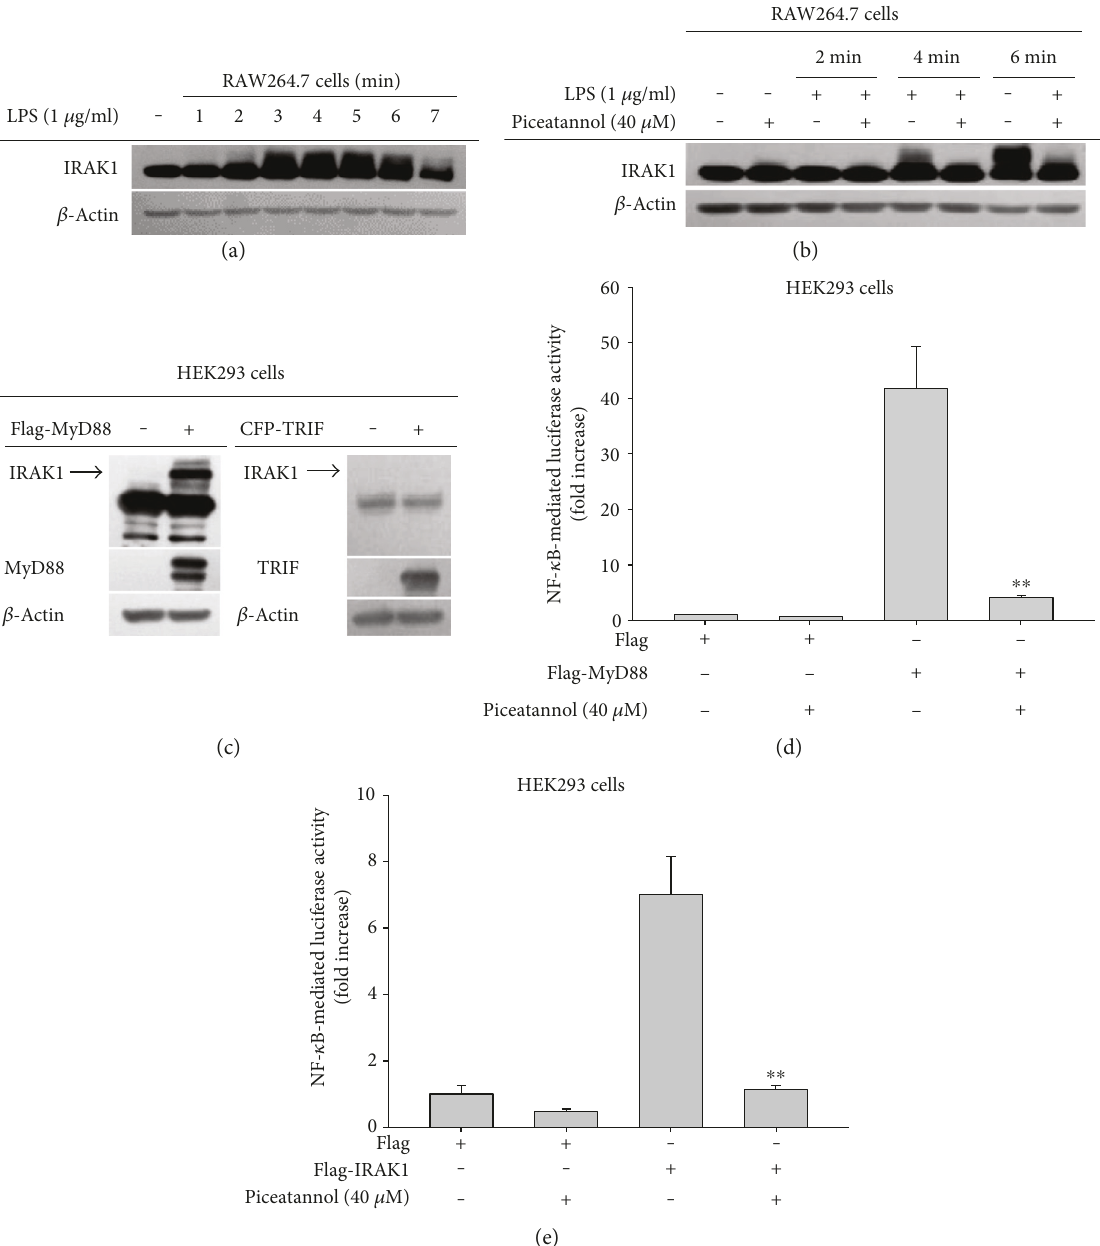
Figure 1: Piceatannol impacts IRAK1 activation during LPS treatment in RAW264.7 cells. (a, b, and c) Protein levels of IRAK1, IRAK4, MyD88, and β -actin as determined by lysate immunoblotting prepared from LPS- (1 μ g/ml) treated RAW264.7 cells or MyD88- overexpressed HEK293 cells. (d and e) HEK293 cells cotransfected with NF- κ B-Luc (1 μ g/ml) and β -gal (as a transfection control) plasmid constructs were treated with piceatannol (40 μ M) in the presence or absence of an adaptor molecule (MyD88) or IRAK1 for 12 h. Luciferase activity was determined via luminometry. All data are expressed as the mean ± SD of three independent experimental replicates. ∗∗ p < 0 01 compared to the control